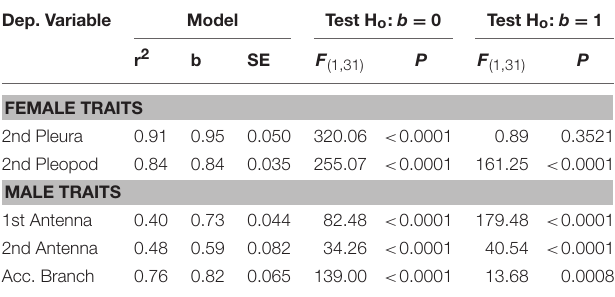
TABLE 3 | Body structures and their variation with body size in Lysmata wurdemanni